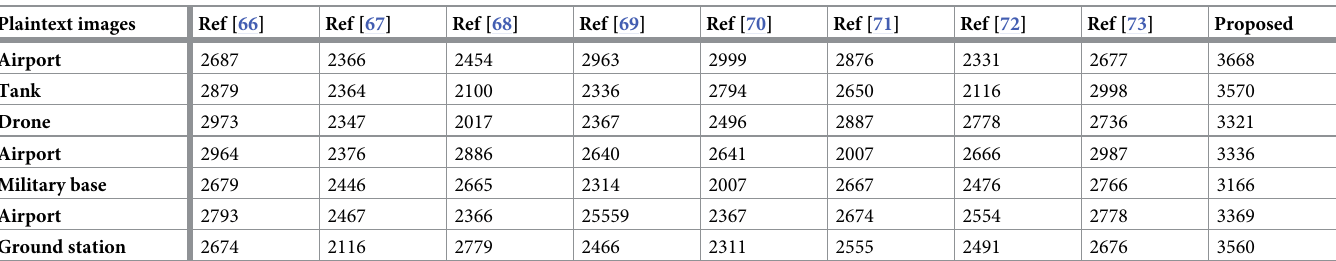
Table 16. MAE analysis.